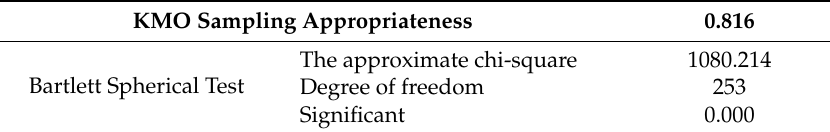
Table 6. KMO and Bartlett spherical test.